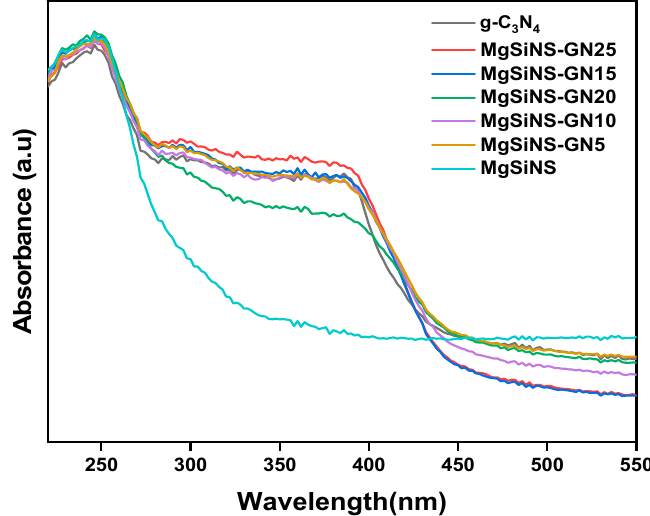
Figure 3. DR UV–vis absorption spectra for all the prepared materials.